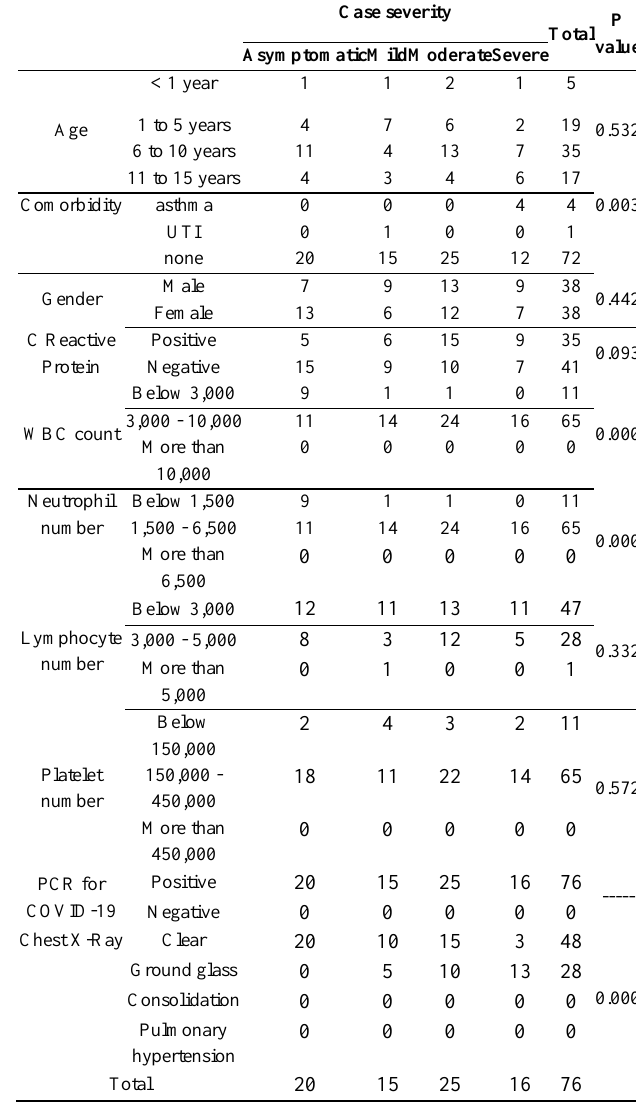
Table 1: sociodemographic and clinical characteristics of the studied population Table 2: characteristics of the studied population